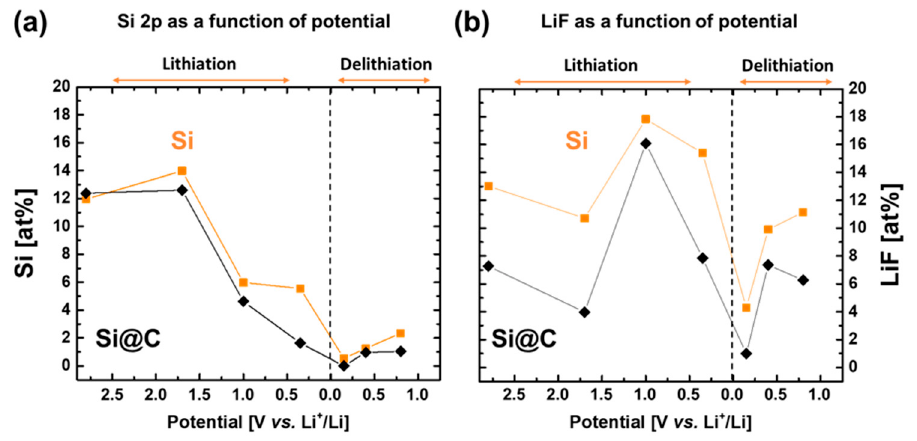
Figure 9. ( a ) Atomic percentages of Si in the total quantification of elements determined by XPS, giving indications of the SEI layer thickness on top of silicon surface; ( b ) atomic percentages of lithium fluoride in the total quantification of elements determined by the peak surface area corresponding to LiF. LiF is the main inorganic component in the SEI.